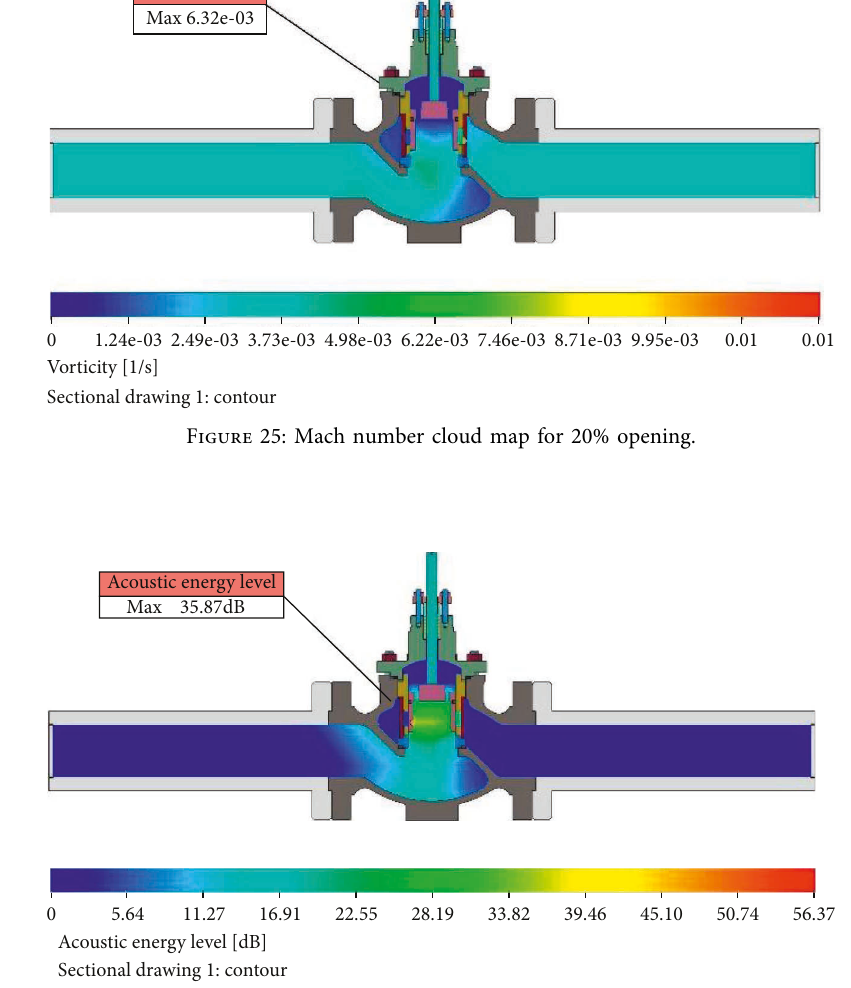
Figure 26: Acoustic energy level cloud map for 20%